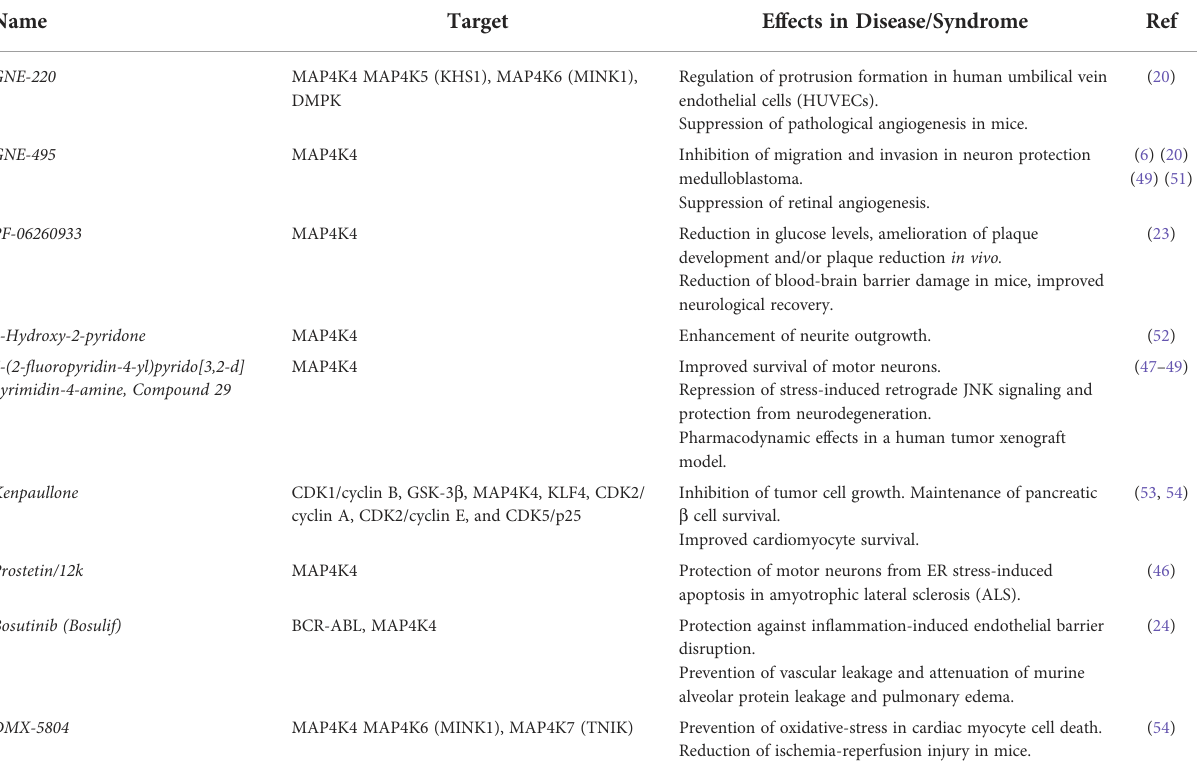
TABLE 1 Inhibitors of MAP4K4 used in different disease